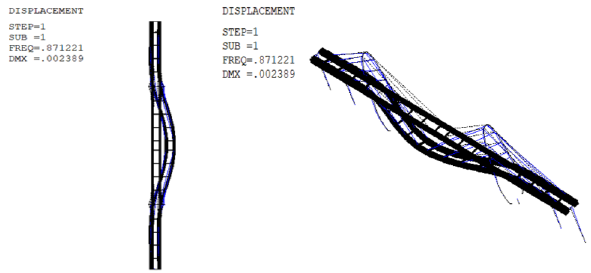
Fig. 1 STM cable-stayed bridge finite element model